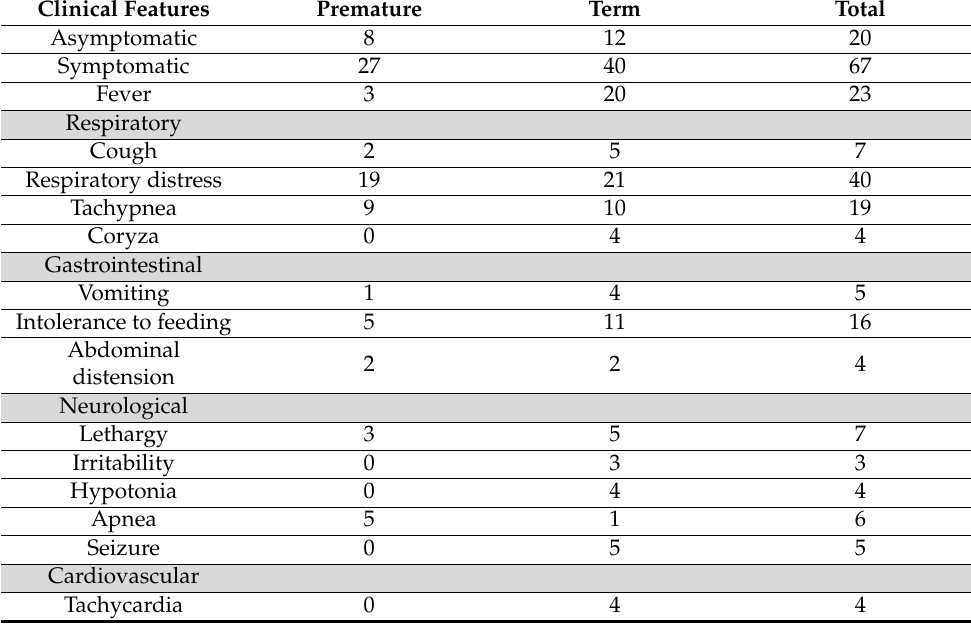
Table 1. Clinical features reported in premature and term